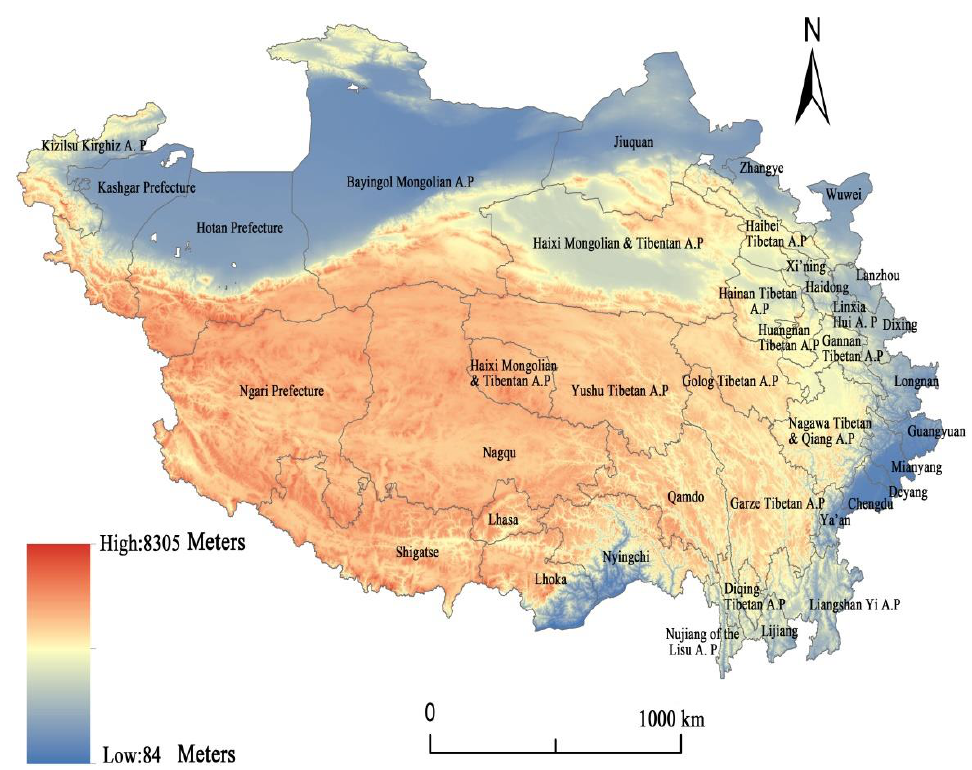
Figure 2. Elevation map of the study area. Note: The white spots on the map represent administrative units in the prefecture-level cities that do not belong to the Qinghai–Tibet Plateau region. The maps below are similar.